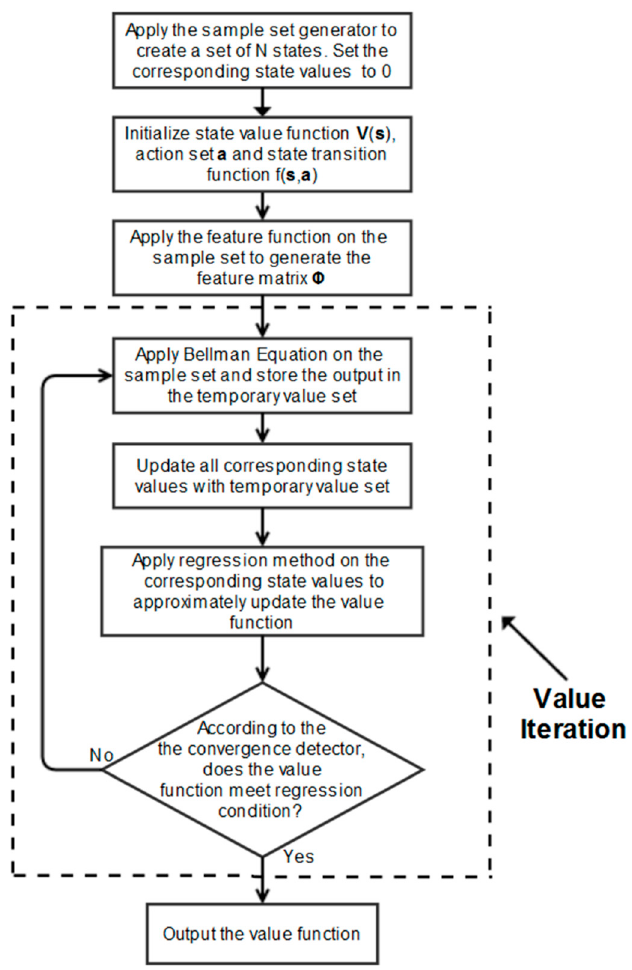
Figure 1. Learning phase flow